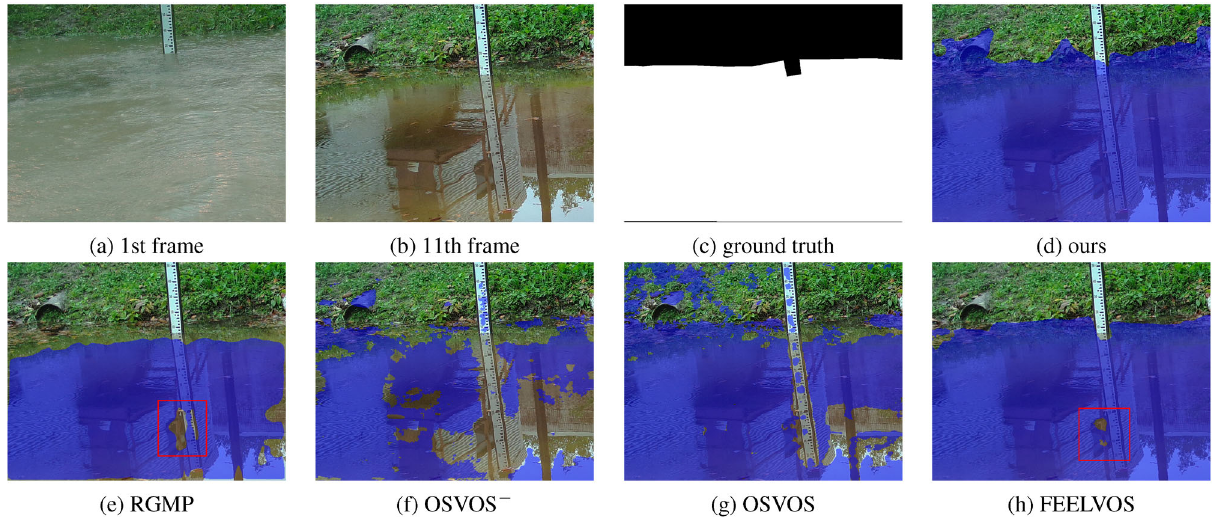
Fig. 7 Qualitative results from test video “stream3”: (a) 1st frame, (b) 11th frame for segmentation, (c) ground-truth water, (d)–(h) segmentations of WaterNet, RGMP, OSVOS without online training, OSVOS, and FEELVOS. Red box highlights artifacts in (e) and